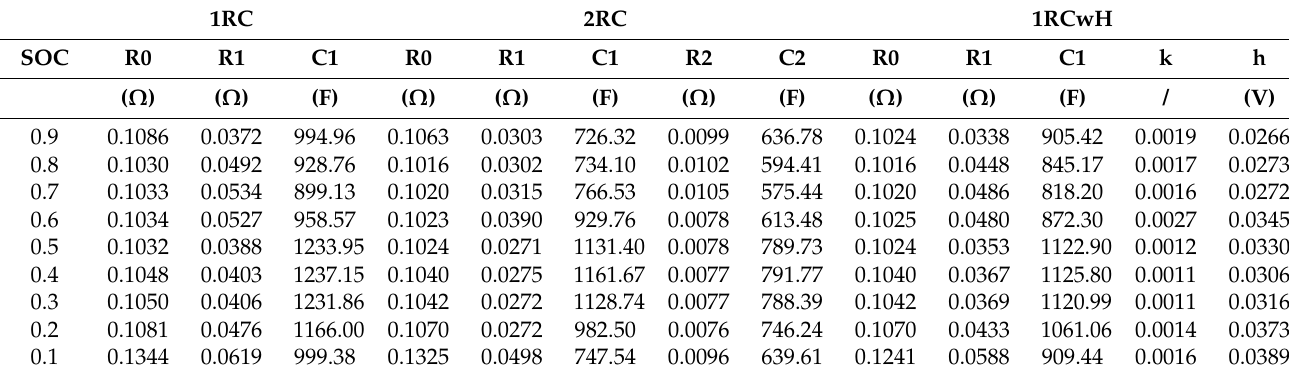
Table 9. Model parameters obtained from HPPC data fitting in MATLAB for the NCA